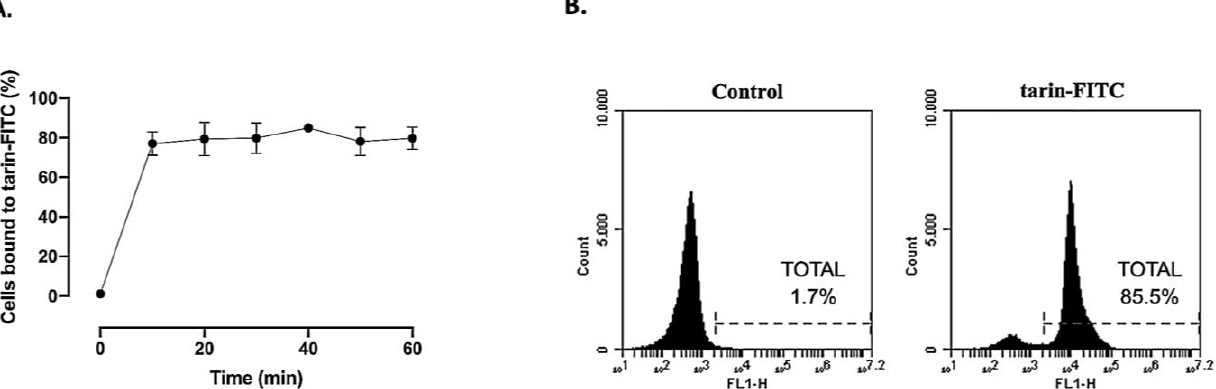
Figure 1. Tarin binding to hematopoietic bone marrow cells. ( A ) Tarin (25 µg/mL) labeled with FITC was added to murine BM cell suspension and the percentage of cells bound to tarin-FITC was monitored every 10 min up to 60 min by flow cytometry. ( B ) Representative histogram displaying the percentage of tarin-FITC-positive bone marrow (BM) cells (tarin-FITC panel) after 60 min and non-stained cells (control panel). Histograms are representative of three independent experiments. Table 1. Dynamic response of bone marrow cells treated with